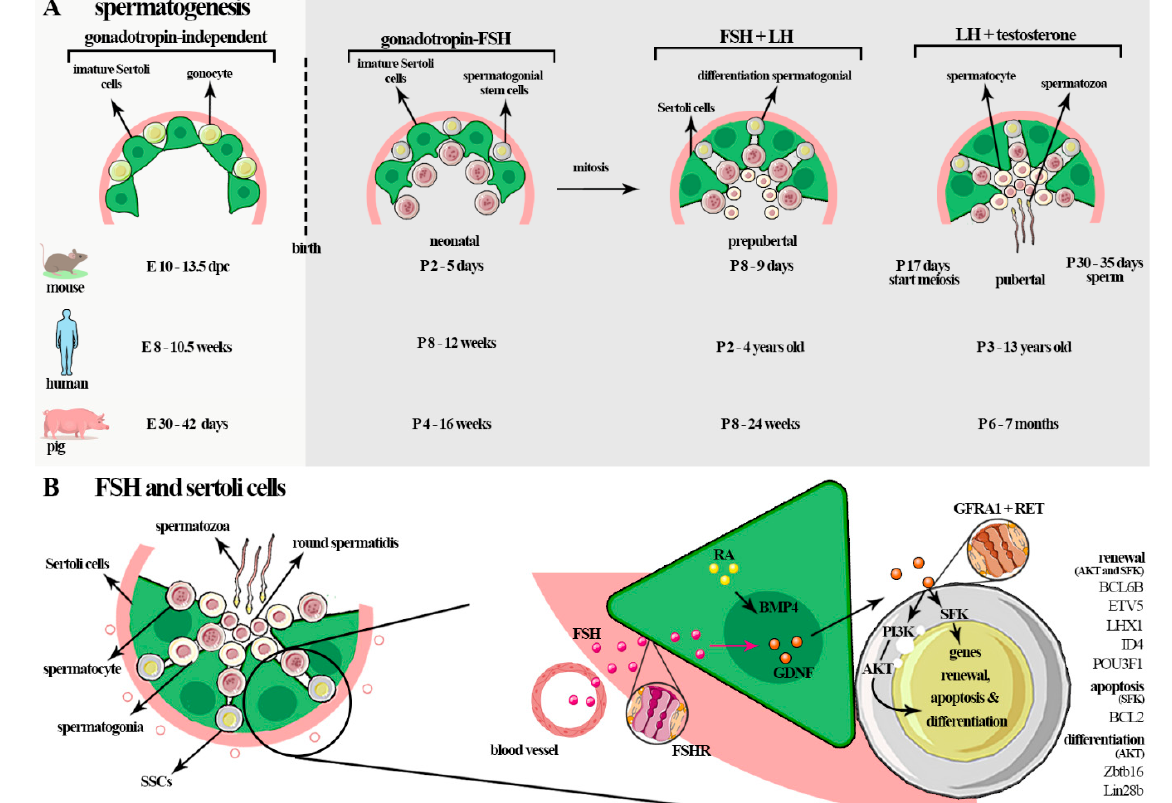
Figure 3. ( A ) In fetal life, PGCs transform into gonocytes that remain centrally placed, surrounded by immature Sertoli cells. In mice, gonocyte development occurs before the formation at E10-13.5 d.p.c, in humans at E 8–10.5 weeks, and in